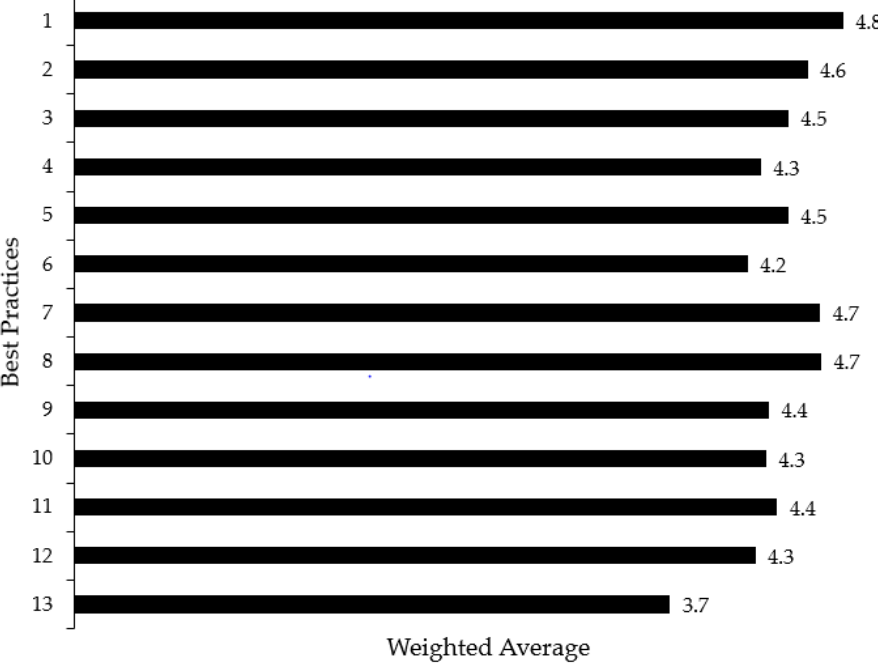
Figure 6. Best practices (weighted opinions) .